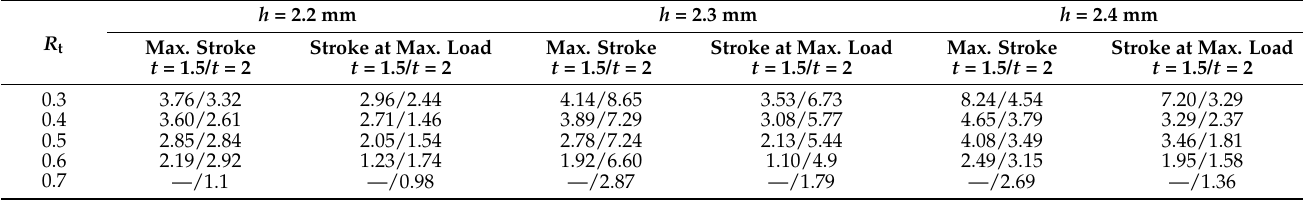
Table 2. Maximum strokes and strokes at maximum load in peel tests (units in